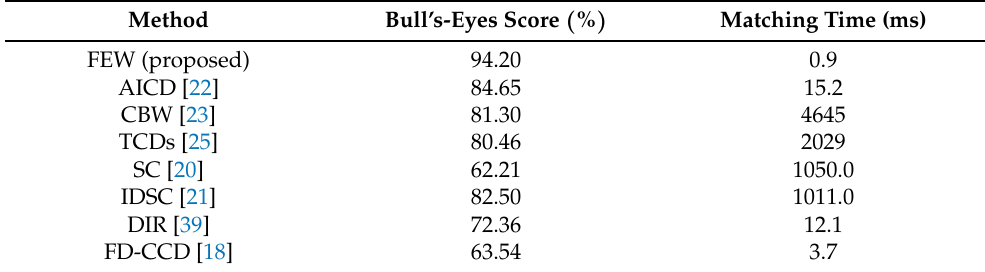
Figure 10. The leftmost column is a schematic diagram of the object shape contour artificially occluded (to verify the effectiveness of the proposed method in the shape recognition stage), and the rest is part of the shapes in MPEG-7 Part B. Table 3. Comparison of the bull’s eyes test score and matching time on MPEG-7 Part B